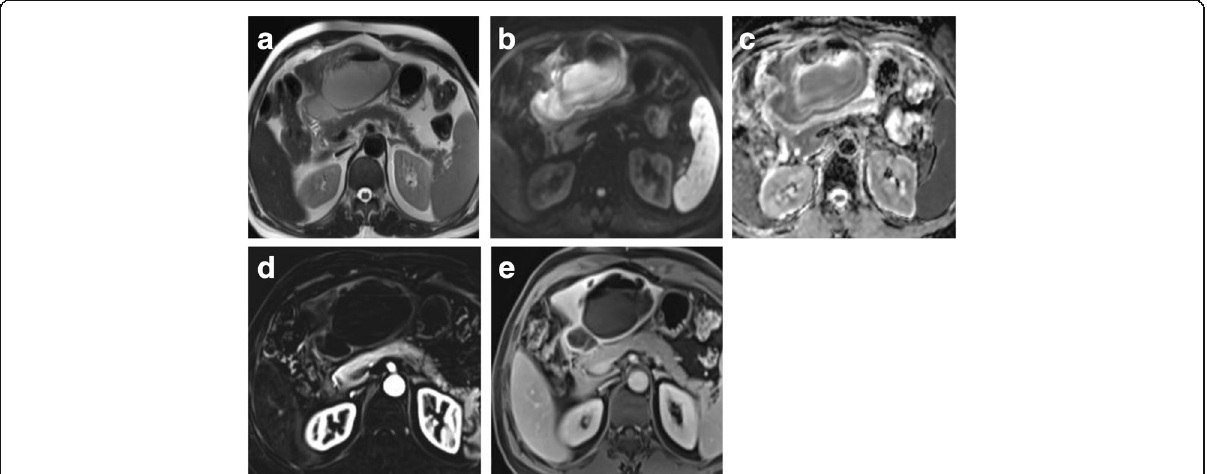
Fig. 9 Hepatic focal lesion after TACE. a T2-WI shows a well-defined cystic lesion at the treated focal lesion with air/fluid level. b , c DWI and ADC show central areas of true restriction. d Subtracted T1-WI arterial phase shows peripheral smooth wall enhancement of the lesion. e Post-contrast T1-WI delayed phase shows peripheral smooth wall enhancement of the lesion. Overall post-treatment assessment is LR-TR nonviable with post- therapy abscess